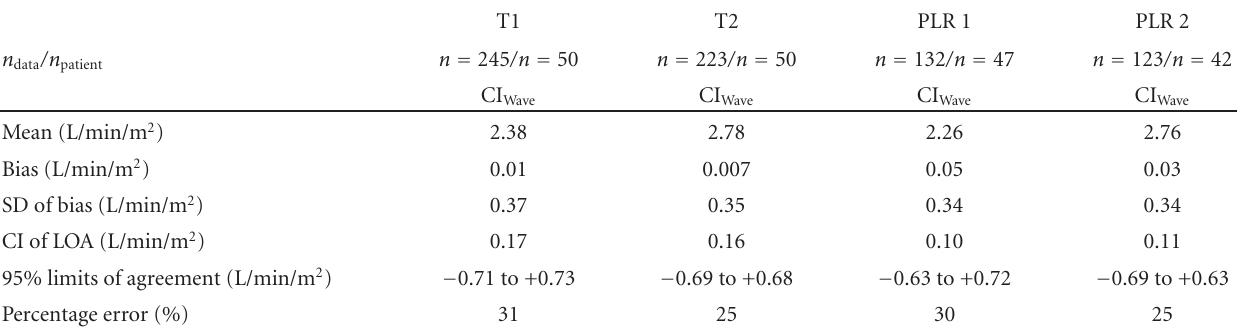
Table 2: Bland-Altman analysis showing 95% limits of agreement, confidence interval, and percentage error before (T1) and after (T2) cardiopulmonary bypass and during passive leg raising before (PLR 1) and after (PLR 2) bypass. T1 T2 PLR